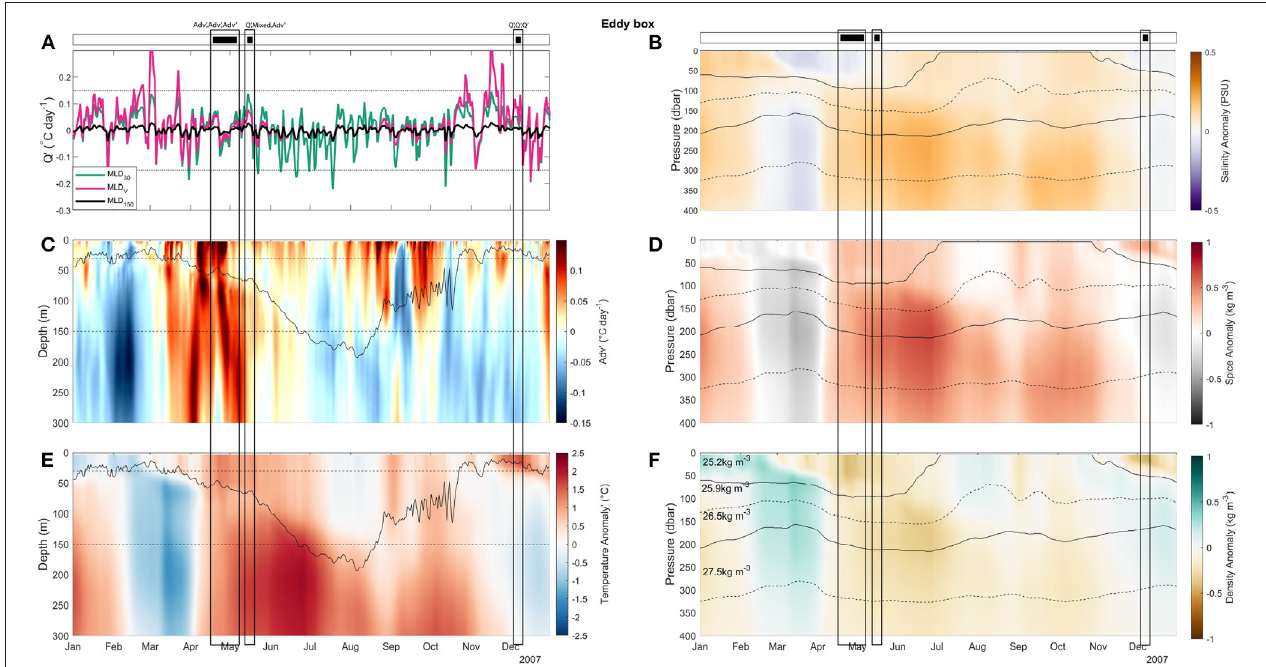
FIGURE 4 | Time-series of air-sea heatflux anomaly during 2007 in the Eddy box (A) as calculated using the three MLDs: MLD 30 (green), MLD V (red), and MLD 150 (black). Dotted lines correspond to the Adv’ colourbar limits in panel (C) . (C) Hovmoller diagrams showing anomalous advection with depth. MLD V is shown with a solid black line, MLD 30 and MLD 150 are marked by dashed lines. (E) Hovmoller diagram showing the temperature anomaly with depth. MLD V is shown with a solid black line, MLD 30 and MLD 150 are marked by dashed lines. (B,D,F) The evolution of salinity (B) , spice (D) and density (F) anomalies against pressure. Isopycnal surface contours of 25.2, 25.9, 26.5, and 27.5 kg m − 3 are shown using alternating dashed and solid lines (as per labels). MHWs are marked in the top panel with black rectangles. Drivers as identified by each scenario: MLD 30 , MLD V , and MLD 150 are labeled above each event in this order.